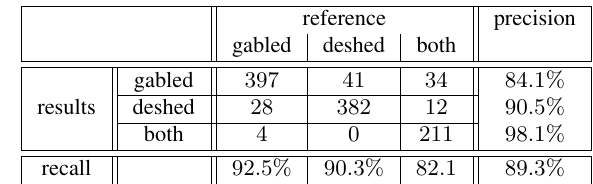
Table 2. Results of the binary classification of roofs and dorm- ers based on simulated data. Point density: 11 points/m 2 , noise: Table 5. multi-class classification results of dormer types using a 7 cm. 10-fold cross validation. Point density: 7 . 5 points/m 2